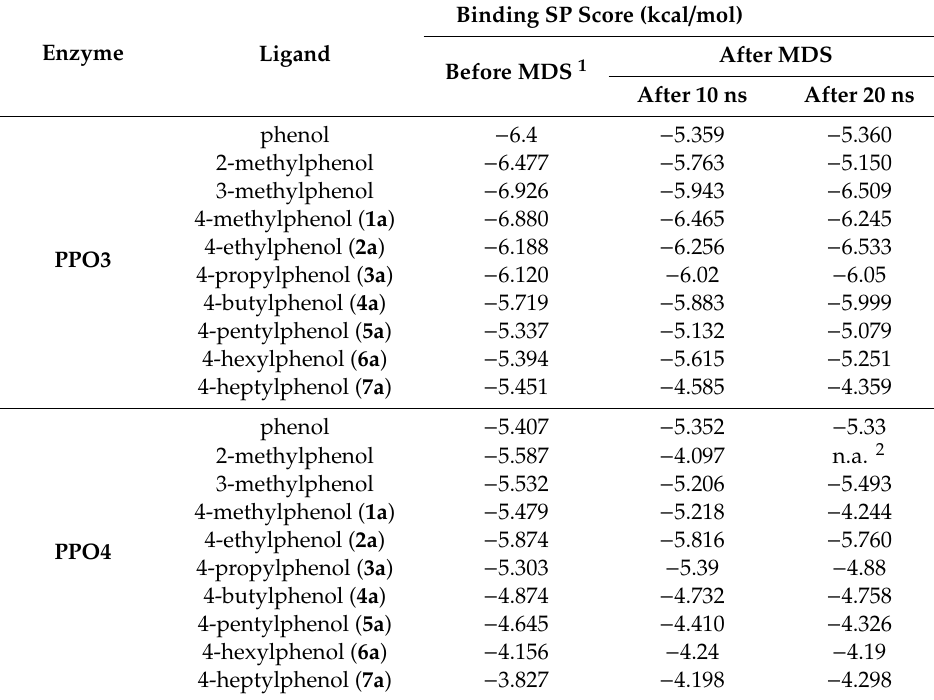
Table 2. Binding glide scores calculated for various ligands docked in the active sites of tyrosinases PPO3 and